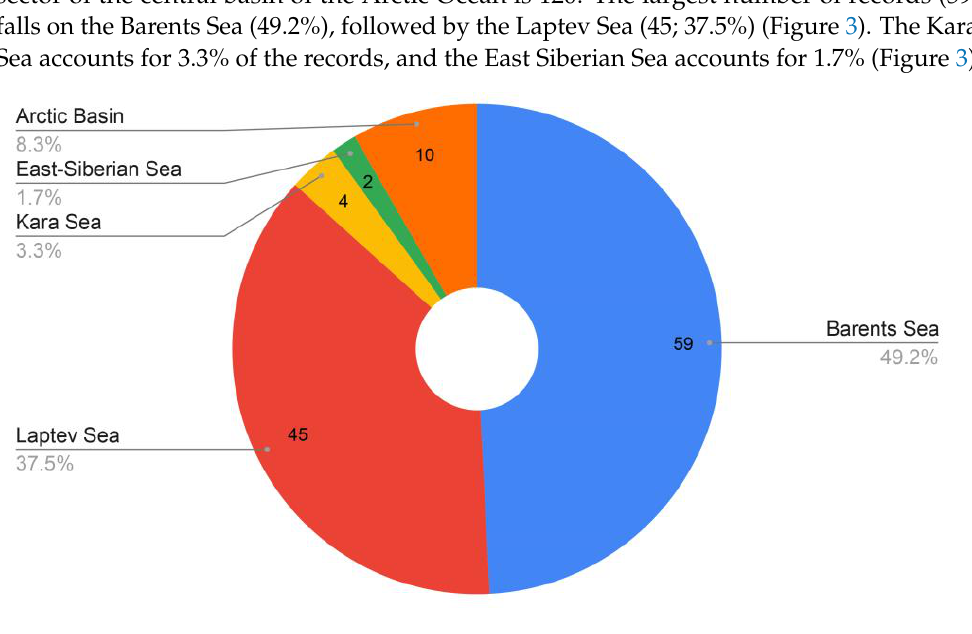
Figure 4. Distribution of siboglinid species by seas. Siboglinids are mainly deep-sea organisms whose representatives mostly inhabit bathyal depths [38,39,72]. In the Russian Arctic, most of the siboglinid records stem from the shelf (Figure 5), with 28% of all records at depths shallower than 200 m. The Barents Sea is characterized by a deep shelf, extending to depths of 300 – 400 m, reflecting a great